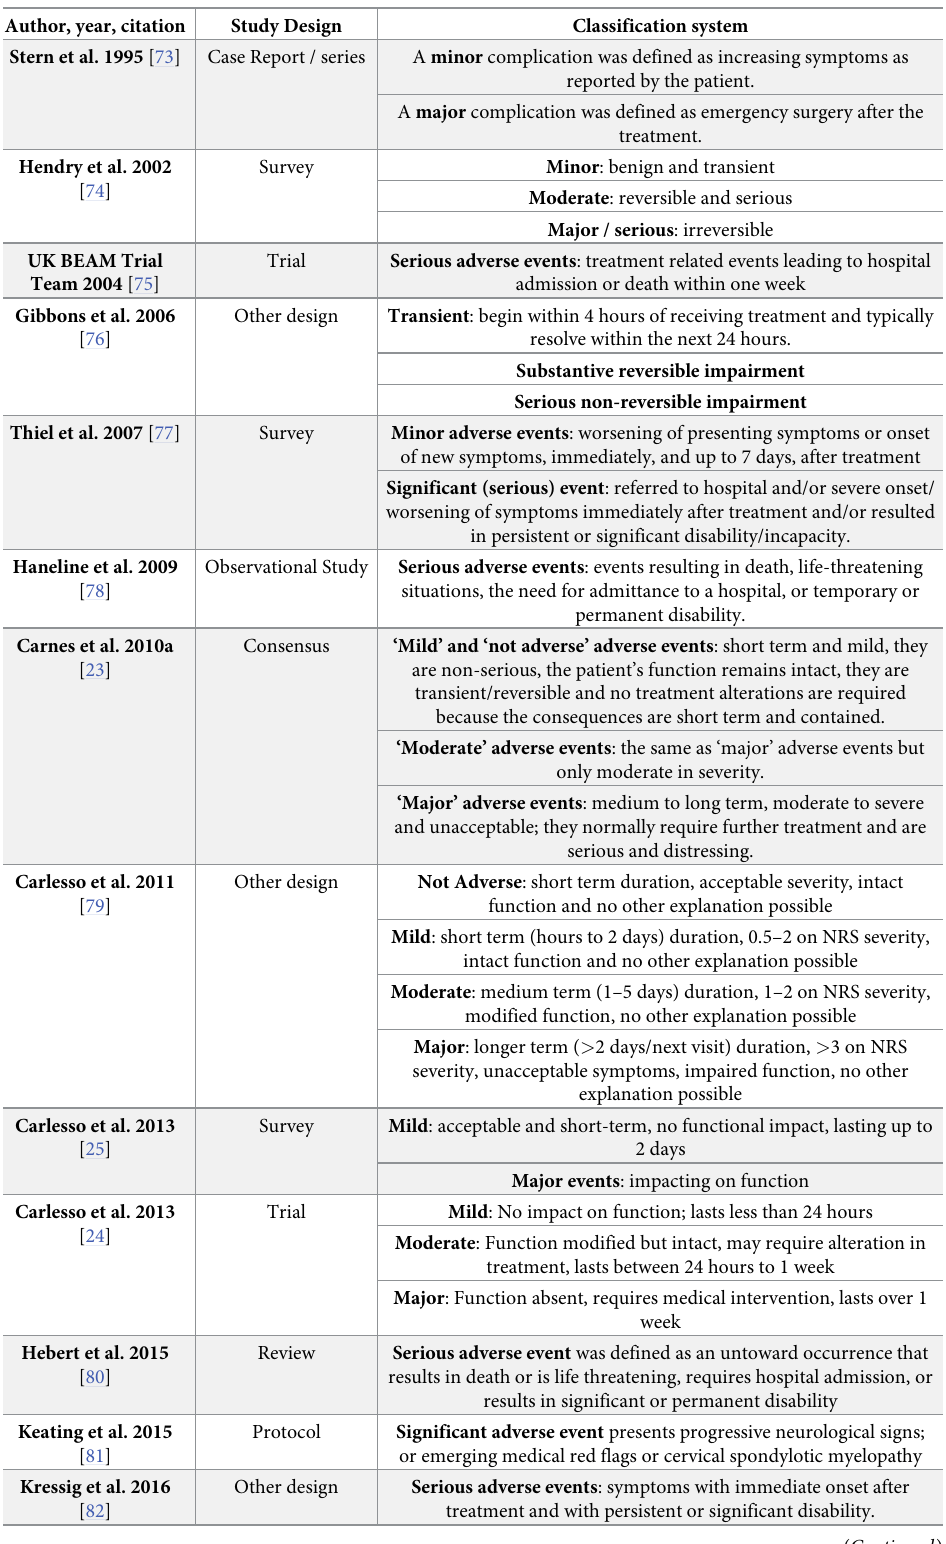
Table 4. Studies providing direct adverse event classification system only (n =